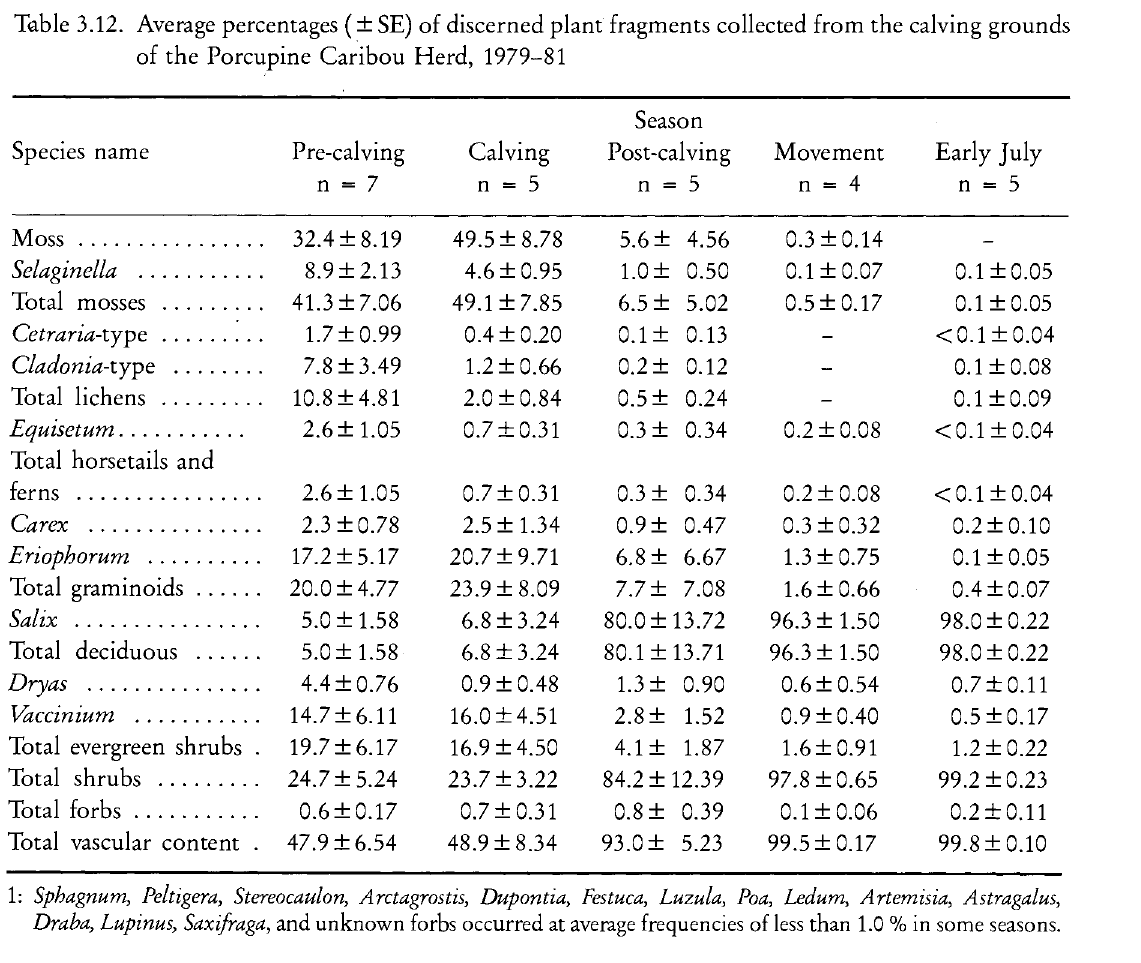
Table 3.12. Average percentages (± SE) of discerned plant fragments collected from the calving grounds of the Porcupine Caribou Herd,